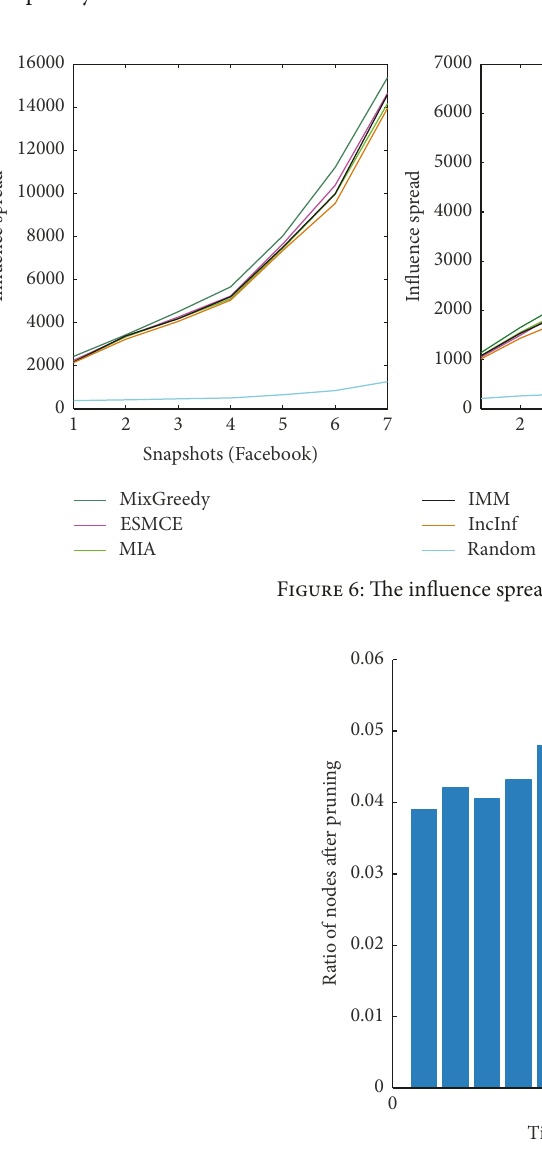
Figure 7: The effect of pruning strategy on the Facebook